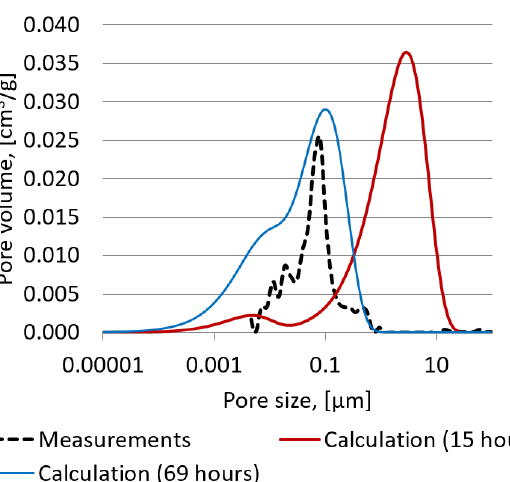
Figure 1. Calculated degree of hydration [24].